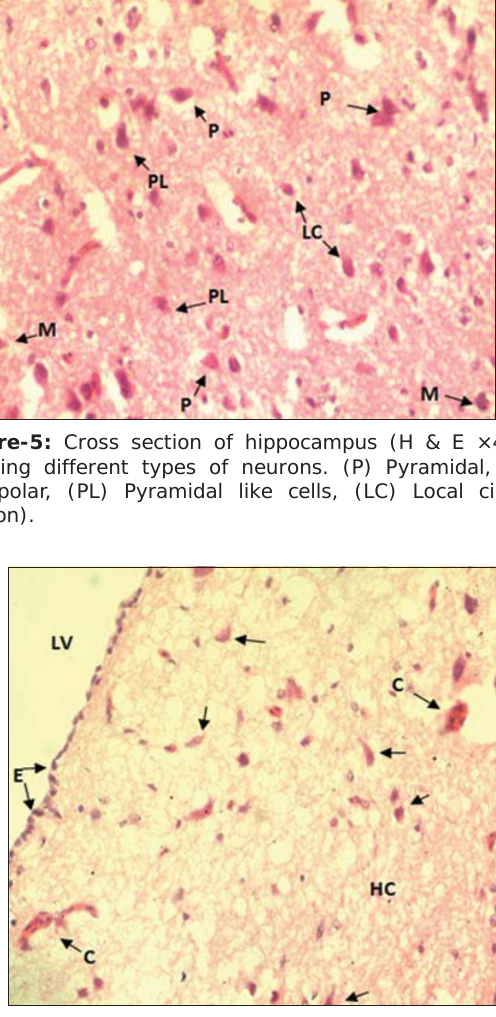
Figure-6: Cross section of hippocampus (HC) (H & E ×400) showing (arrows) Neurons, (C) Capillaries and (E) Ependyma, (LV) Lining of the lateral ventricle.